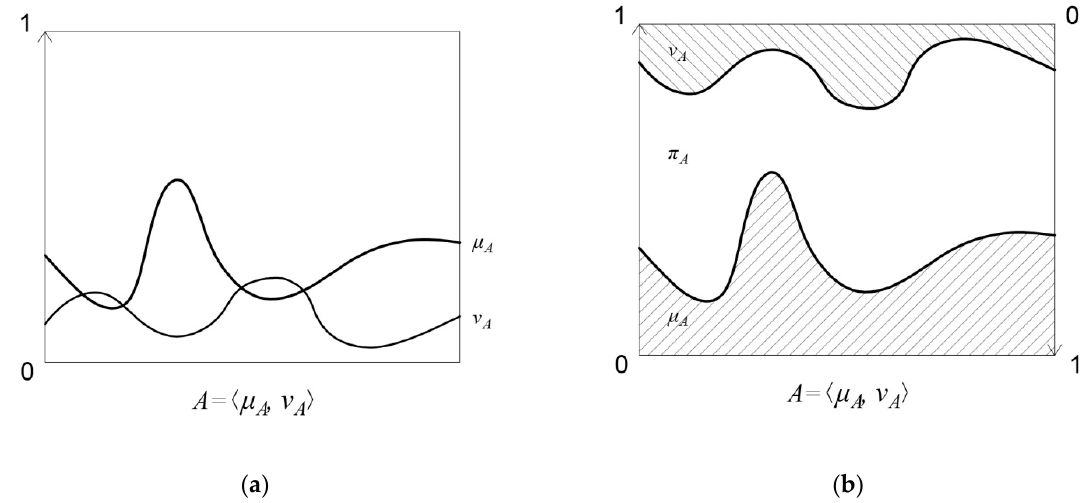
Figure 1. Graphical representation of an arbitrary IFS: ( a ) Standard geometrical interpretation of the IFSs; ( b ) geometrical interpretation with invert axes in order to emphasize uncertainty degree.